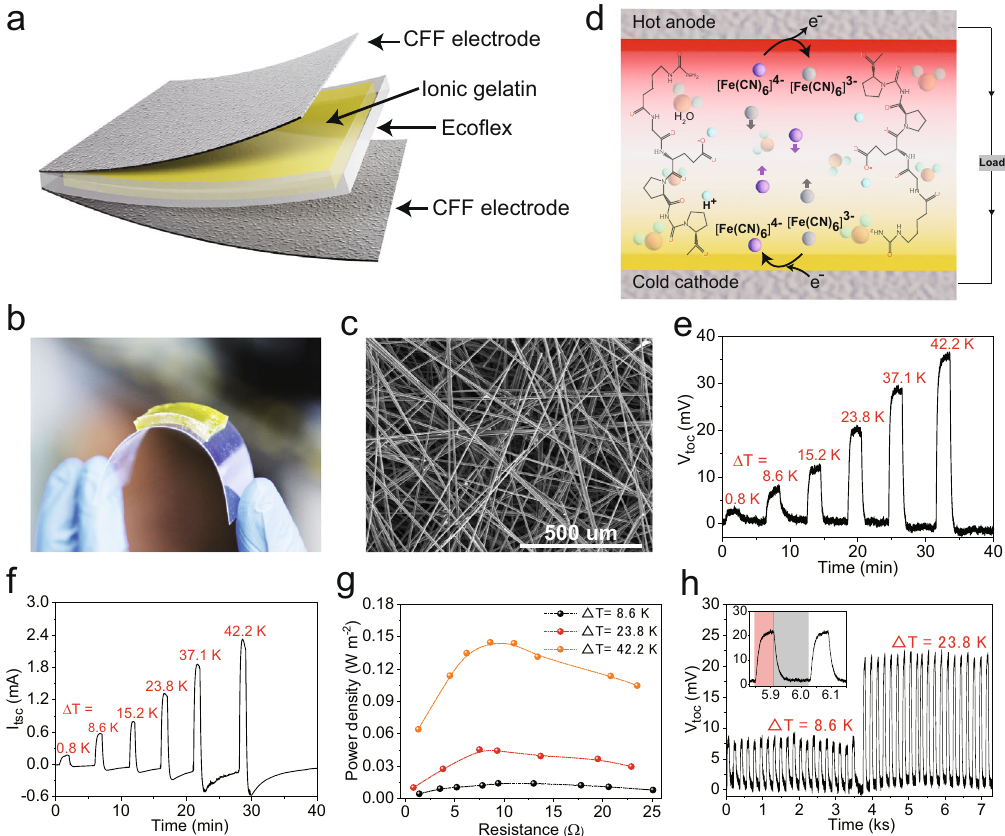
Fig. 3 Composition and power generation performance of the fl exible TG module. a Schematic diagram of the construction of a fabricated TG. b Optical image of the quasi-solid-state ionic gelatin on the bent PET fi lm showing the fl exibility of the i-TE material used. c SEM image of the CFF fi lm. d Schematic fi gure of the diffusion, redox reaction, and interaction of the ions in the fabricated fl exible ionic gelatin under a temperature gradient. e Voltage generated from the as-fabricated TG at different temperature gradients. f Short-circuit current response versus time curve at different temperature gradients. g Corresponding power density at different load resistances under Δ T of 8.6, 23.8, and 42.2 K. h Change in voltage under a cyclic heat gradient (temperature change) from 0 to 8.6 K and 0 to 23.8 K over 20 cycles. Inset: Partial enlargement of the curve. The light red area represents the thermal is applied and the light grey area represents heat is